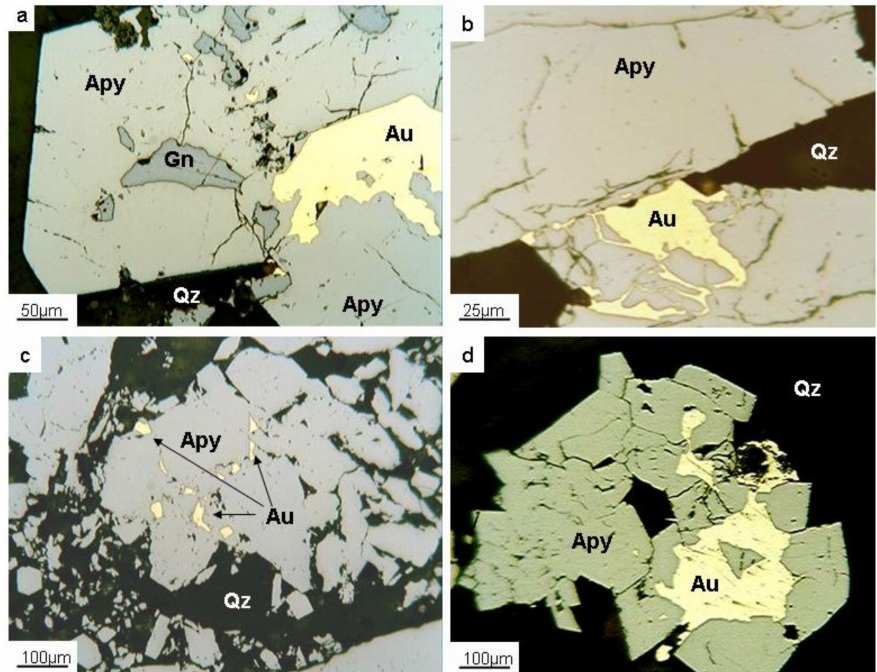
Figure 3. Typical mineral intergrowths of native gold in ores of gold–arsenic-sulfide GIT deposits: ( a ) intergrowth with arsenopyrite (Natalka); ( b ) development of native gold along cracks in arsenopy- rite (Karalveem); ( c ) small inclusions of native gold in a single crystal of arsenopyrite (Degdekan); ( d ) overlay of native gold on an intergrowth of arsenopyrite crystals